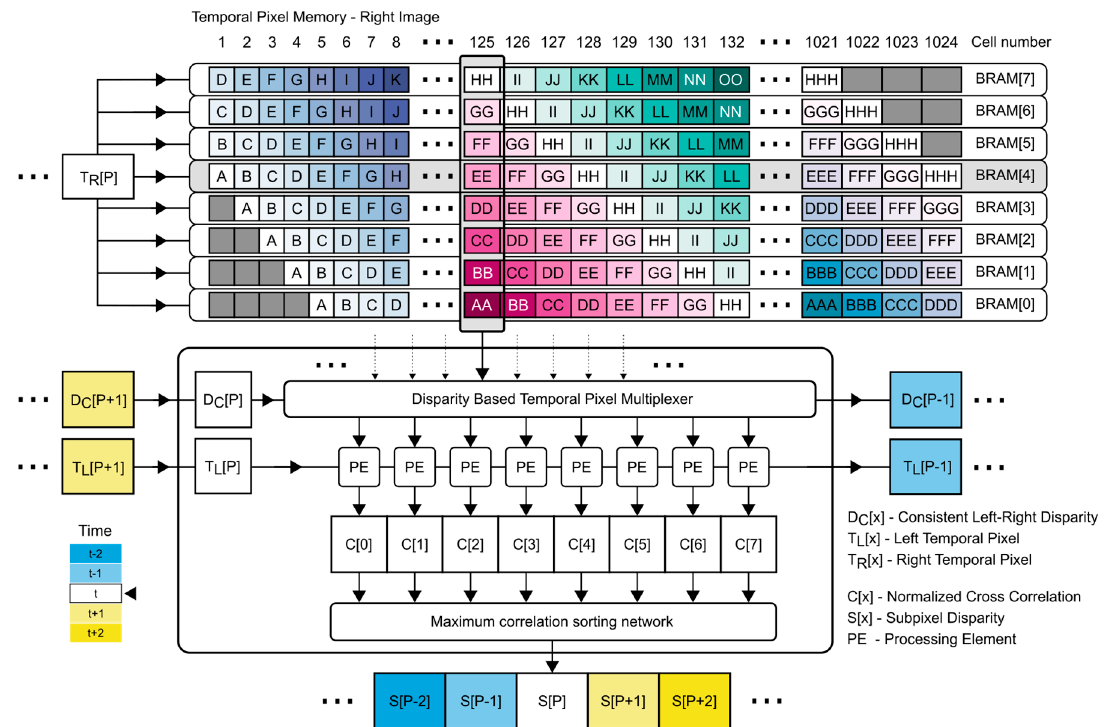
Figure 7. A high-level overview of the subpixel refinement process. Each Block RAM can hold a full image line of temporal pixels. Each read cycle, the right temporal pixel is saved into every Block RAM structure (8 in this case) at the respective memory locations (diagonal). Color codes indicate the clock cycle of writing. Characters are used to display the memory contents.